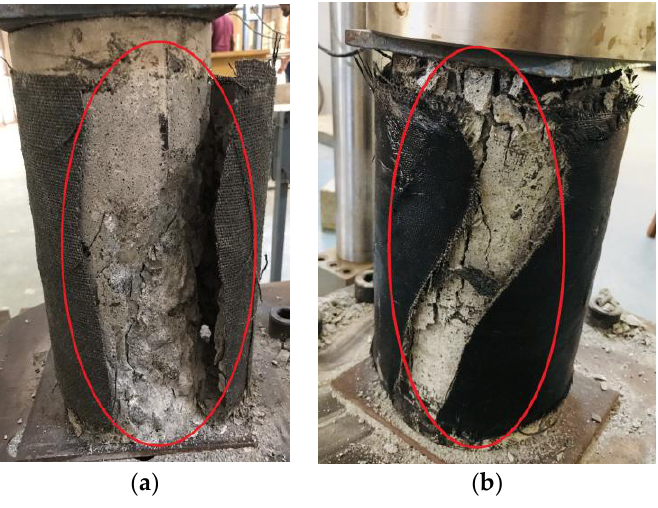
Figure 8. Failure pattern of ( a ) C-C1S2 ( b )